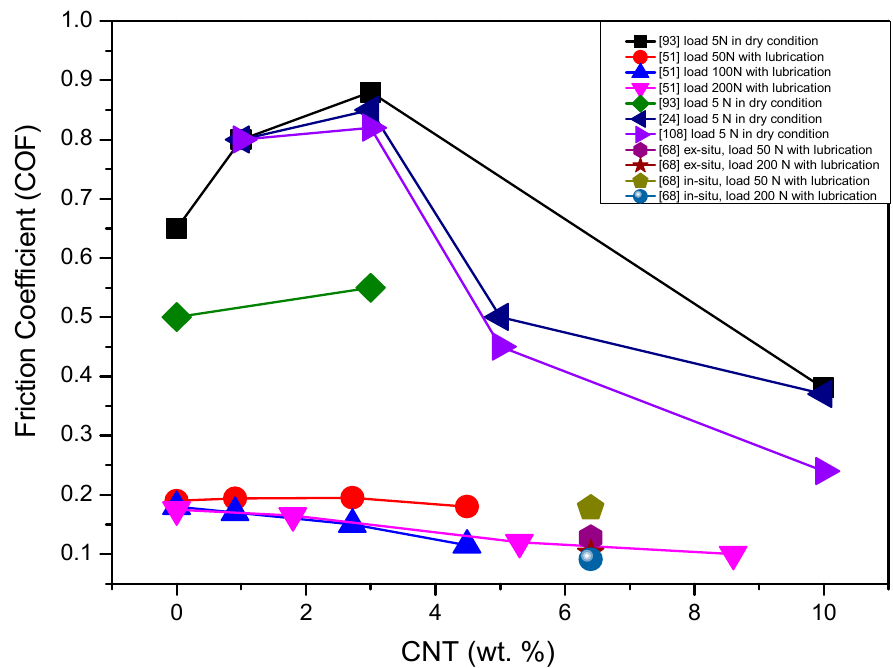
Figure 12. Influence of the CNTs addition on the wear rate of Si 3 N 4 + CNT composites reported by different researchers.